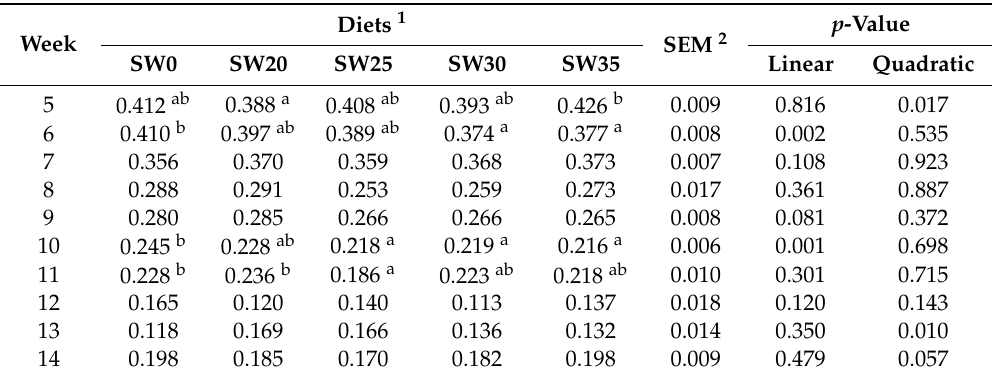
Table 6. Average weekly feed conversion e ffi ciency of Boschveld indigenous hens fed diets containing seaweed